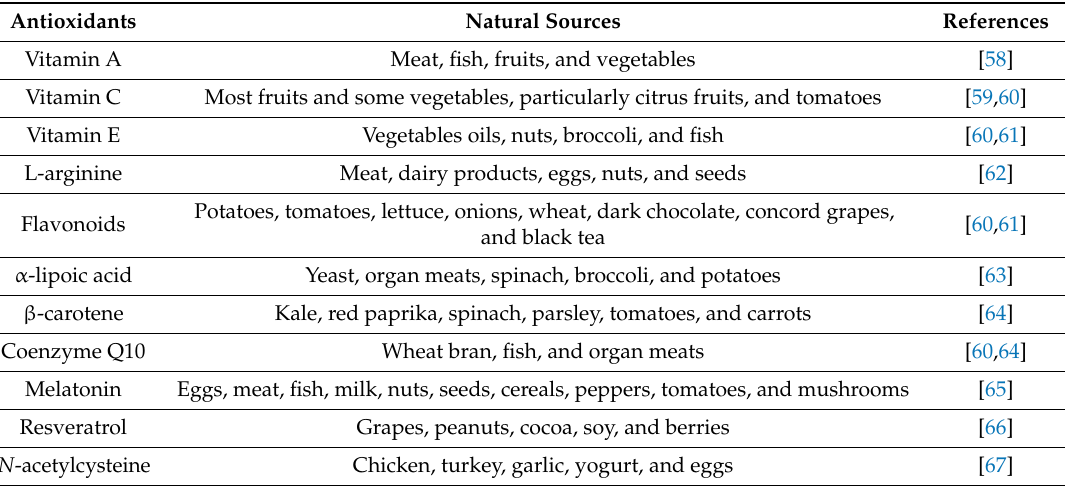
Table 1. Di ff erent sources of natural